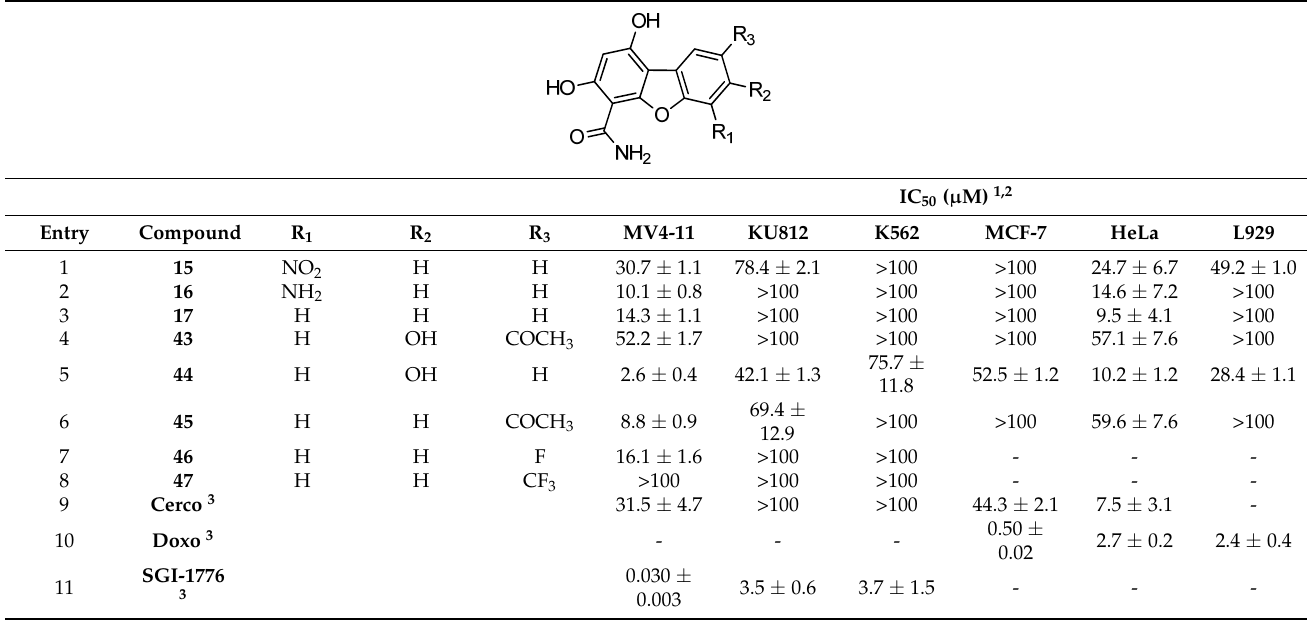
Table 3. Cell-based assays of representative dibenzo[ b , d ]furane derivatives.